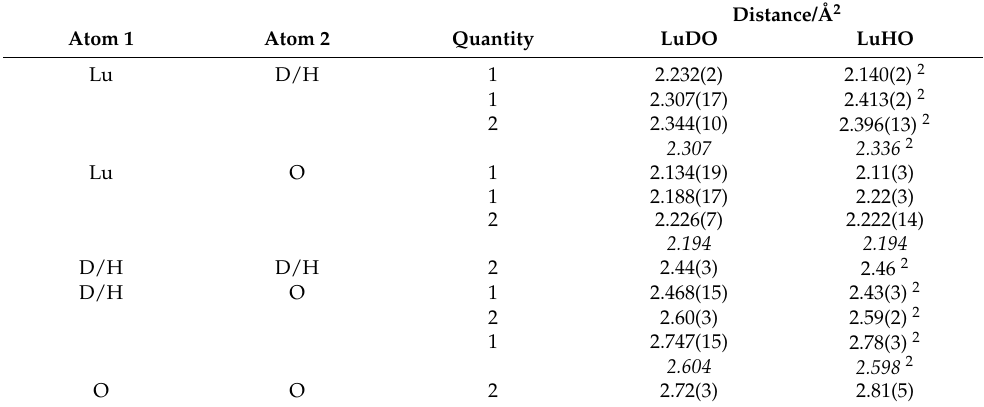
Table 3. The interatomic distances in orthorhombic LuDO based on neutron diffraction data and orthorhombic LuHO based on X-ray diffraction data at ambient temperatures. Mean values are